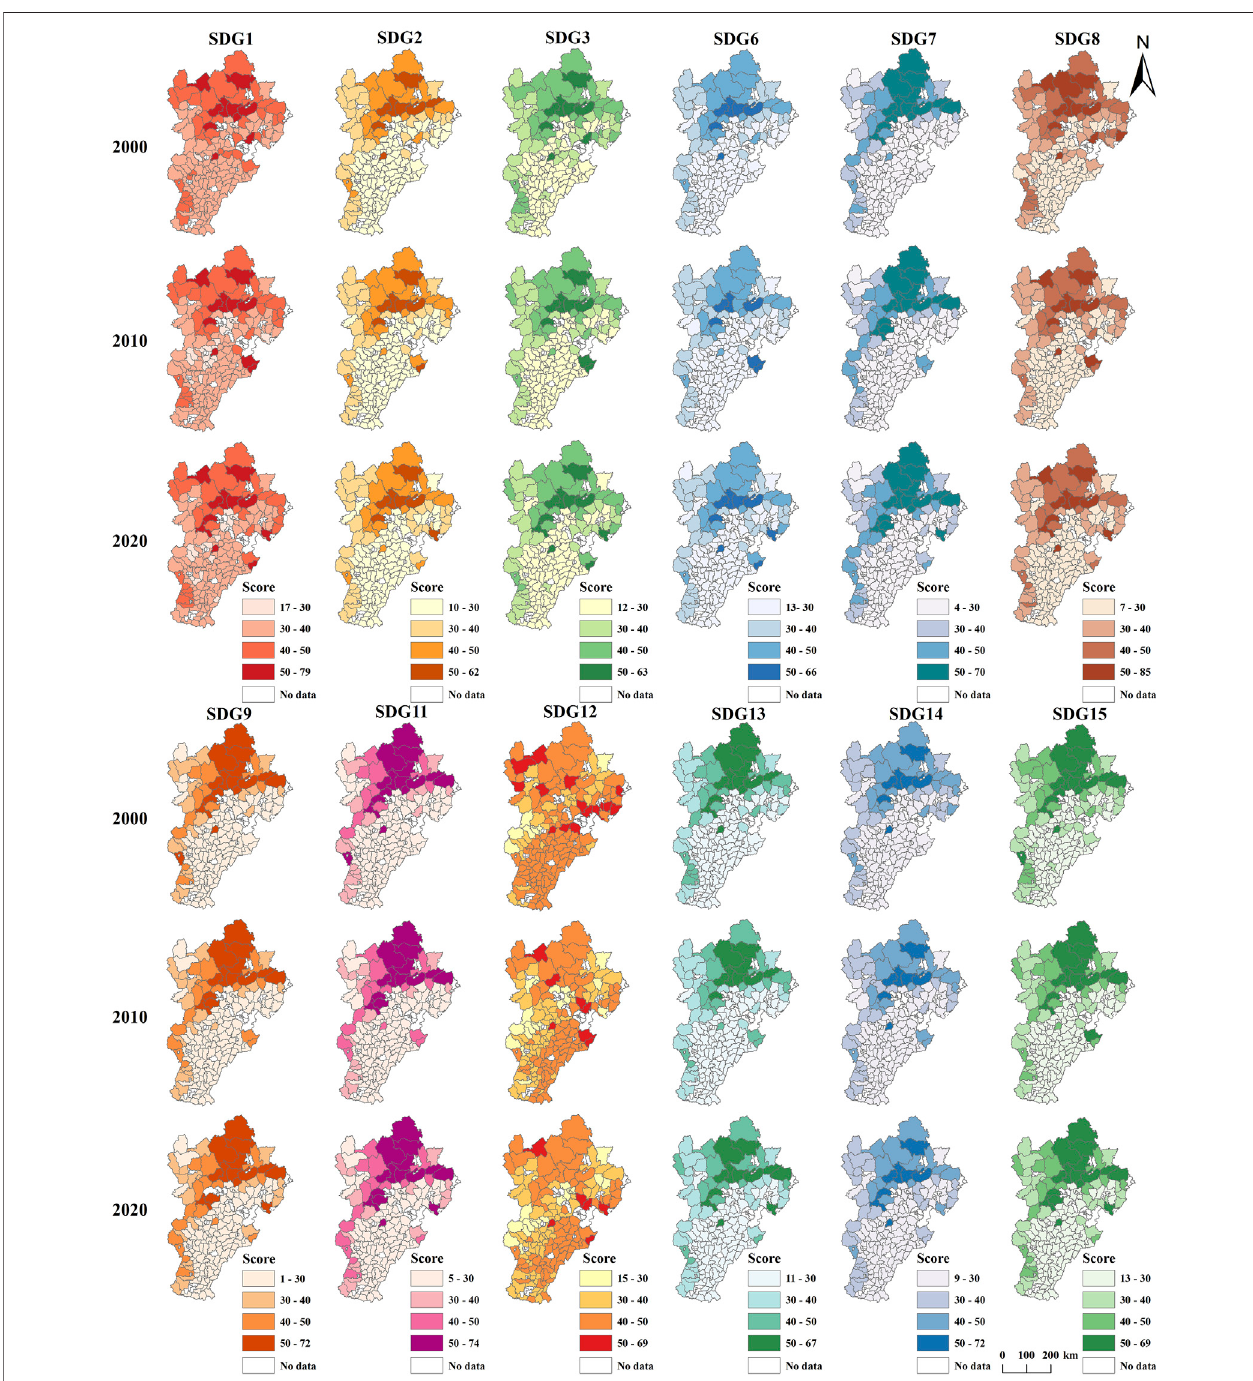
FIGURE 7 | Spatial patterns of individual SDG scores in the Beijing-Tianjin-Hebei